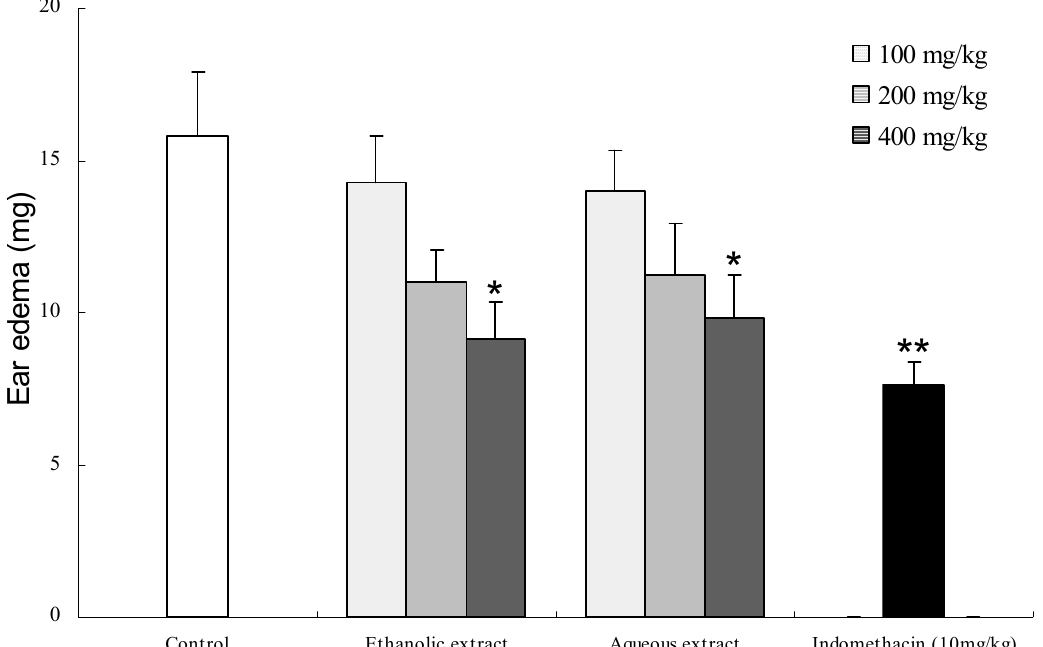
Figure 3. Anti-inflammatory effect of two SL extracts on croton oil-induced ear edema in mice.